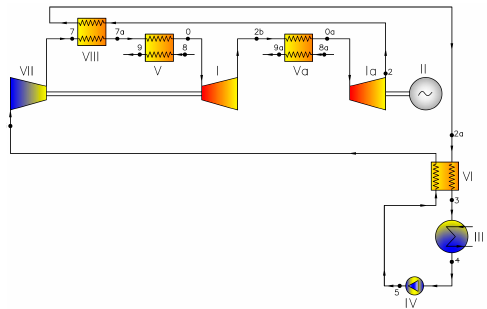
Figure 4. ORC cycle with regenerator, compressor and reheater; where: I—turbine, II—generator, III—condenser, IV—pump, V—vapor generator, VI—regenerator, VII—compressor, VIII—heat exchanger (Variant 6).